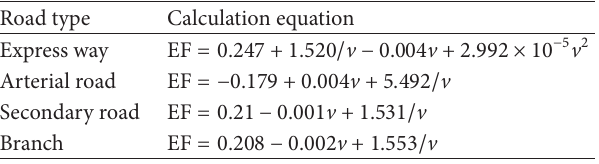
Table 3: Energy consumption factor